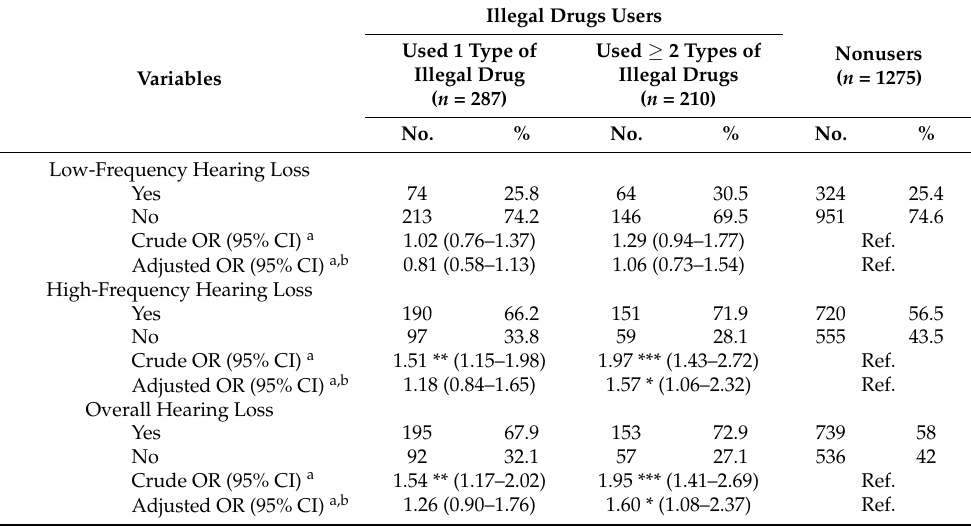
Table 3. Prevalence, odds ratios, and 95% confidence interval for low-frequency hearing loss, high- frequency hearing loss, and hearing loss, stratified by the numbers of illegal drug use.